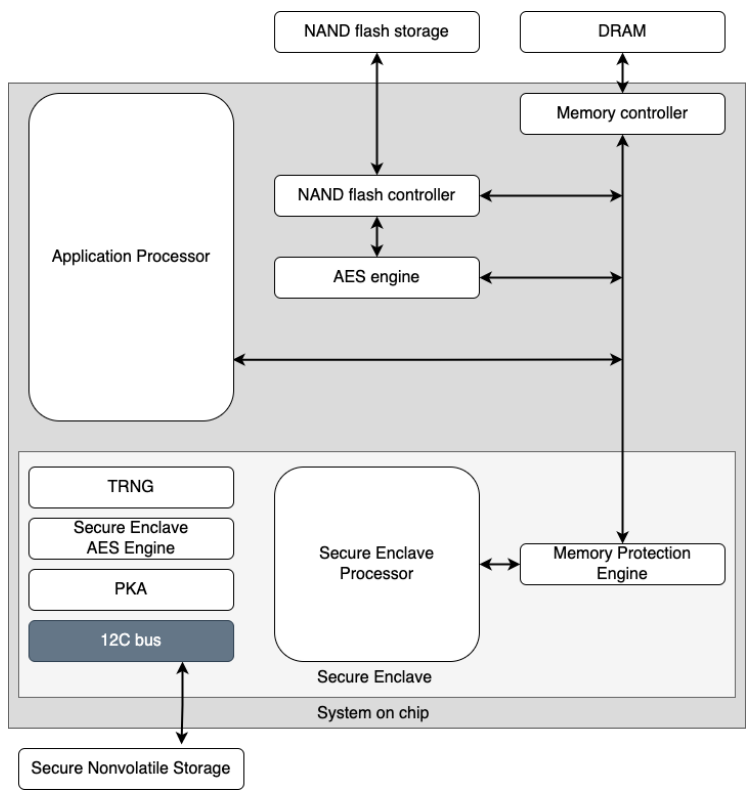
Figure 1. Hardware–software interaction of the Secure